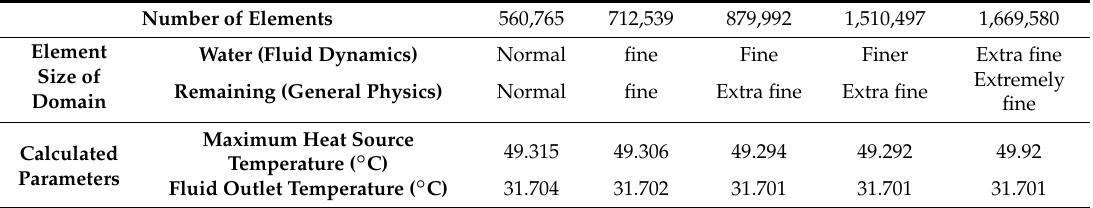
Table 7. Calculated temperature variation with number of elements for three-layers, 30 mL/min and 15 W heating